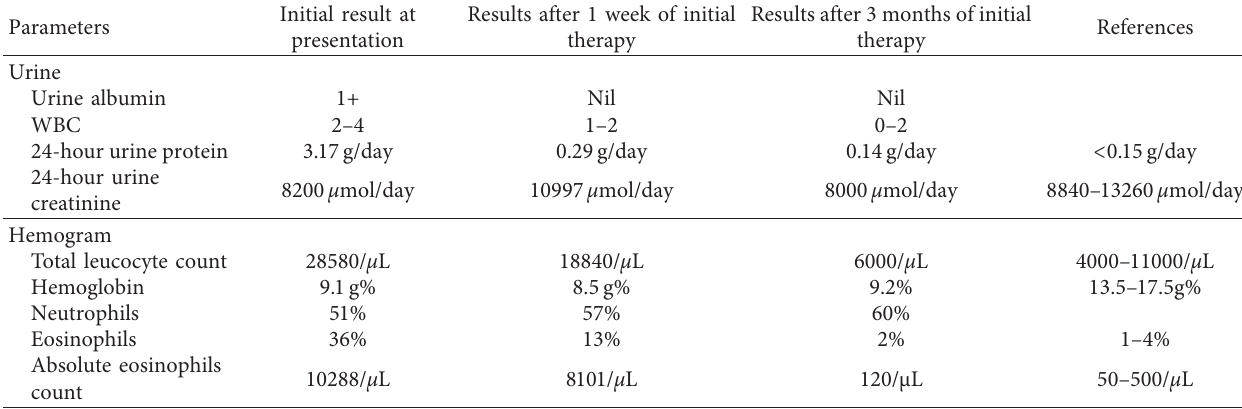
Table 1: Laboratory findings of the